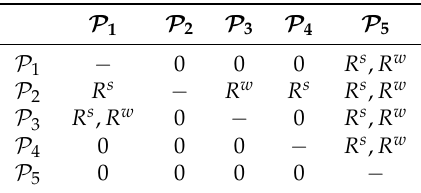
Table 7. Outranking relation.